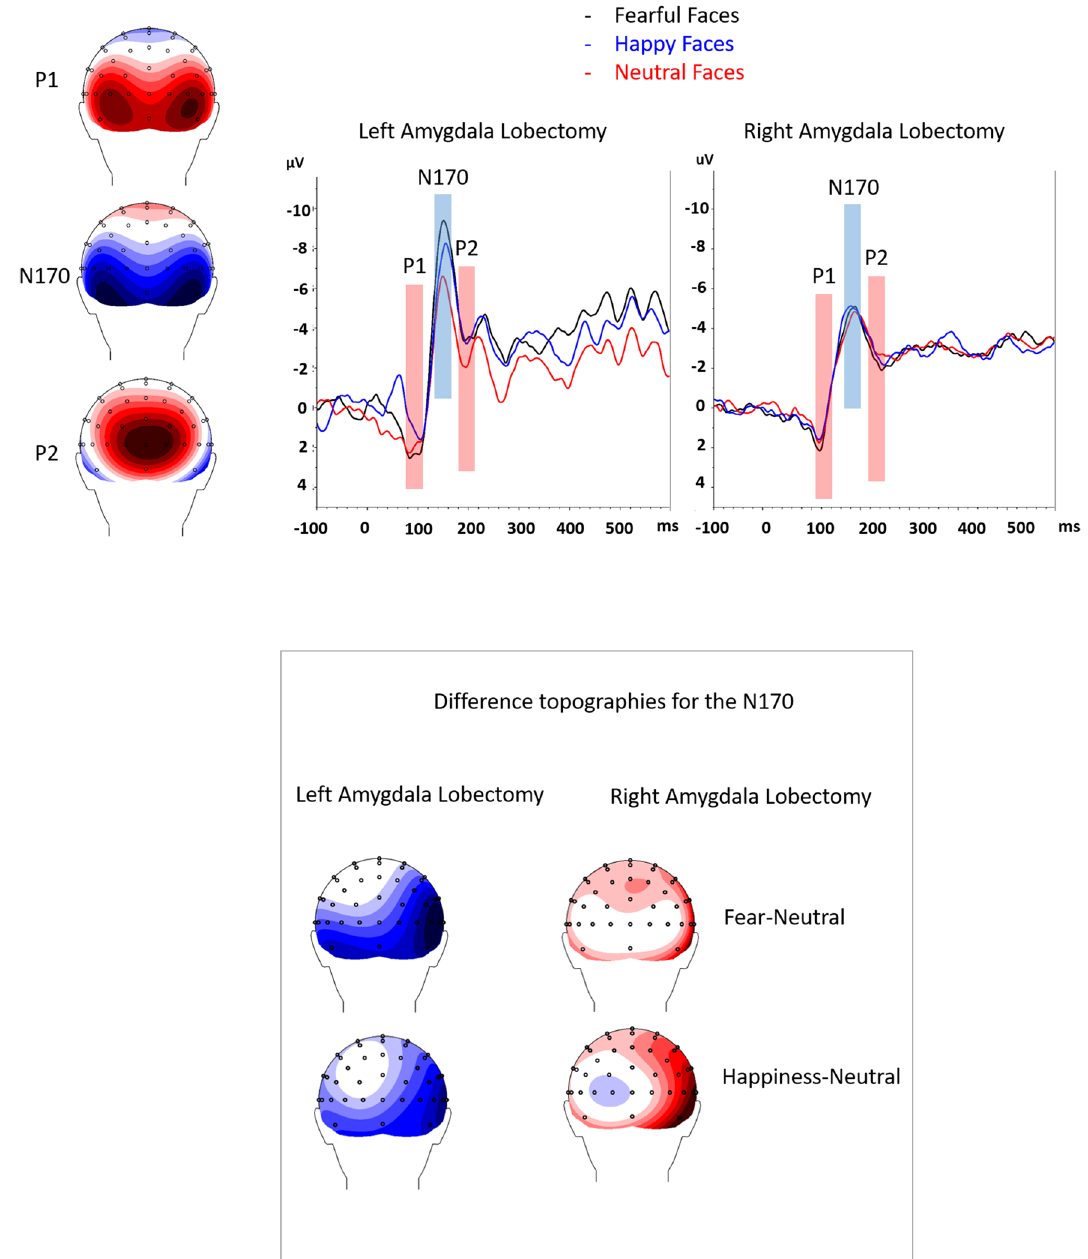
Figure 2. The N170 for the left and right amygdala lobectomy is shown for fearful faces (black), neutral faces (red) and happy faces (blue) conditions. Left and right hemispheres are collapsed. On the bottom, we displayed the difference topographies between the fearful and the neutral conditions and between the happiness and the neutral conditions for the N1 of patients with left and right amygdala